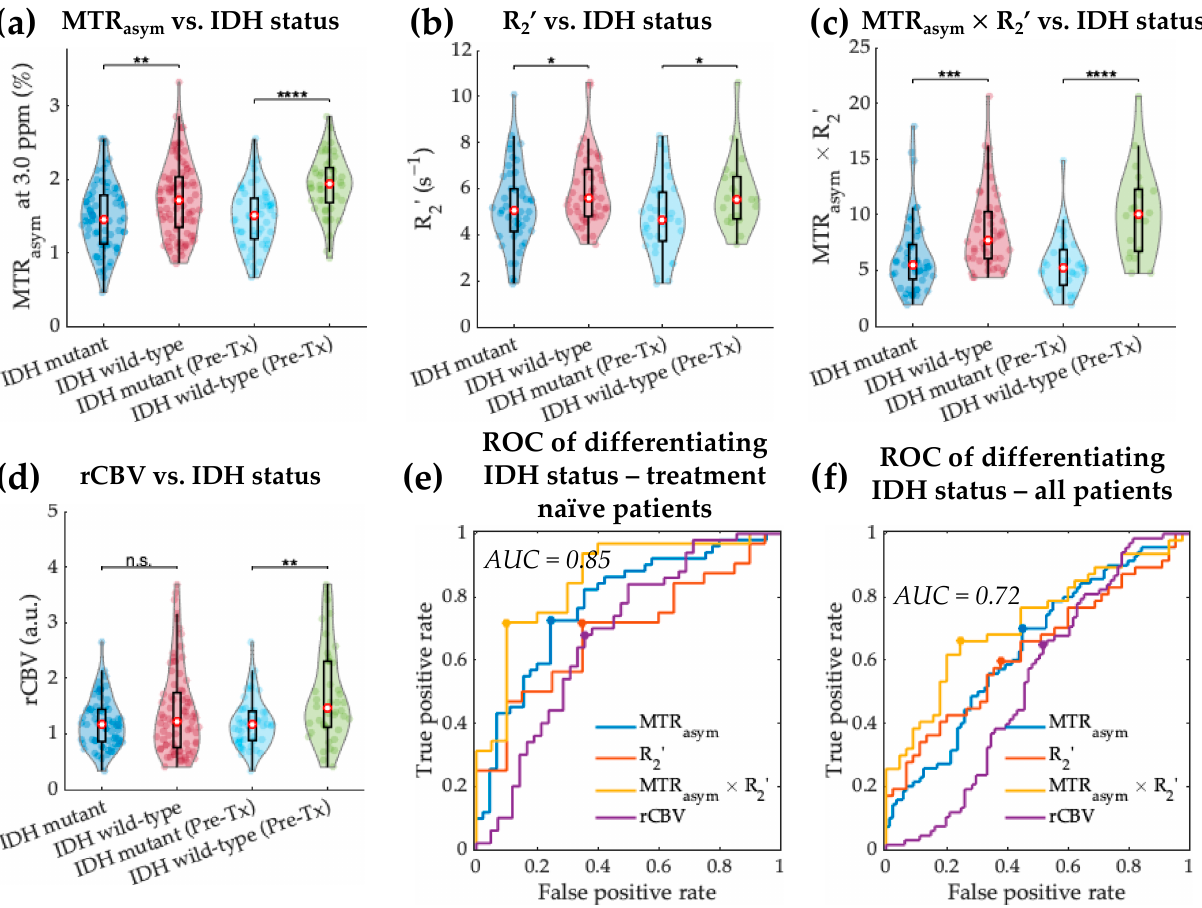
Figure 4. IDH status differentiation based on MTR asym , R 2 ’, MTR asym × R 2 ’, and rCBV. Violin plot graphs of IDH mutant and wild-type gliomas imaging features ( a – d ) are demonstrated for both the entire patient cohort and treatment-naïve patients. The red dots represent the median value, while the upper and lower edges of the box plots represent the 25th and 75th percentile values, respectively. The receiver operating characteristic curves for treatment-naïve patient cohort are plotted in ( e ), showing the best differentiation with MTR asym × R 2 ’ (AUC = 0.85). ROC curves for all patients are plotted in ( f ). *: p -value < 0.05; **: p -value < 0.01; ***: p -value < 0.001; ****: p -value < 0.0001; n.s.: non-significant.